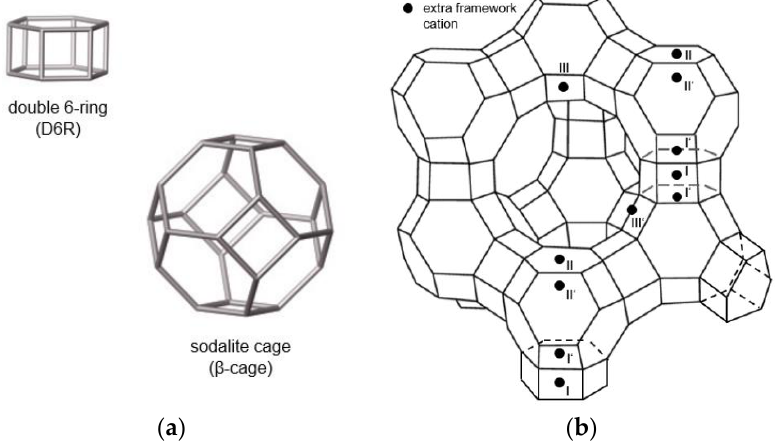
Figure 4. ( a ) Double 6-ring (D6R) and sodalite cage ( β -cage); ( b ) Structure of faujasite zeolite with extra framework cations